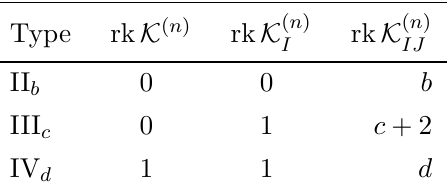
Table 3 . We list the singularity types arising in the large volume regime, when sending multiple coordinates t 1 , . . . , t n i . Note that the ranks rk(number) and rk(vector) are either 0 or 1 → ∞ depending on whether the number and vector are vanishing or